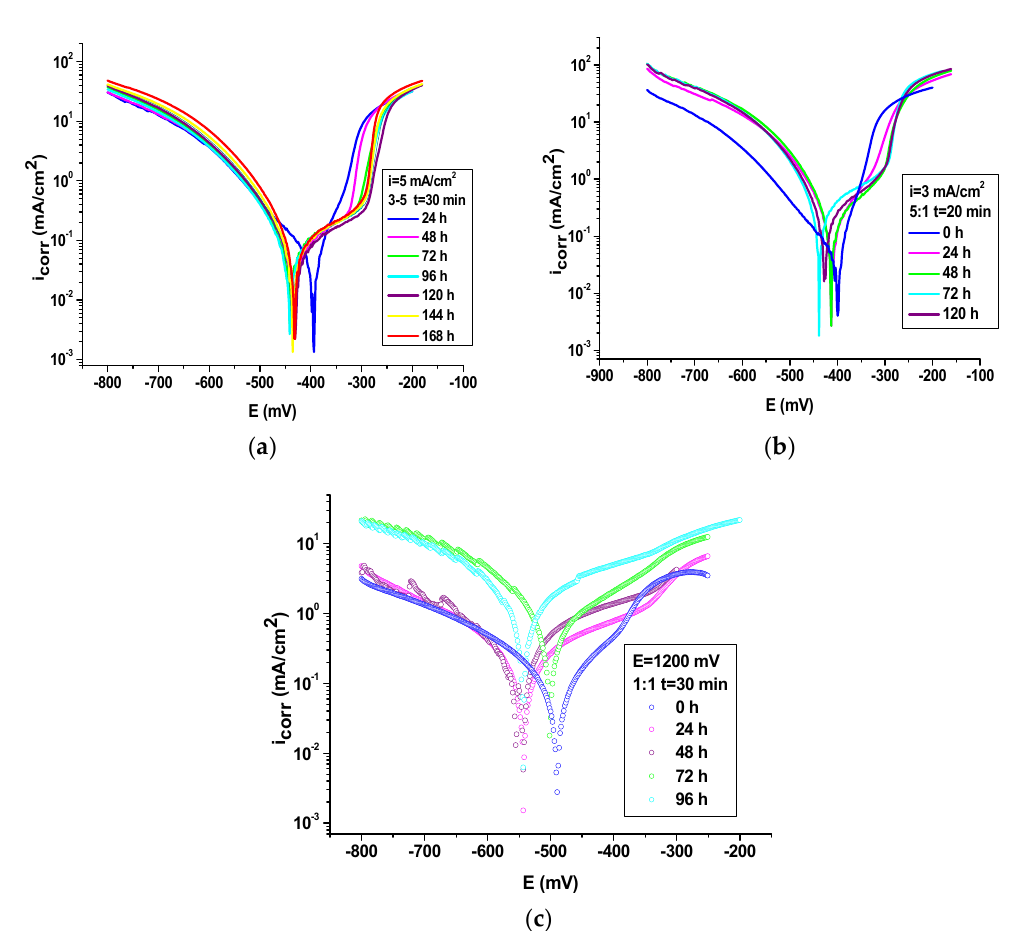
Figure 7. Polarization curves of PNMPY-TW20/P3MT coated and uncoated OLC 45 sample in 0.5 M H 2 SO 4 by electrochemical polymerization at ( a ) 5 mA/cm 2 , ( b ) 3 mA/cm 2 current density and 1.2 V (c) potential with differing molar ratio at varied immersion times.